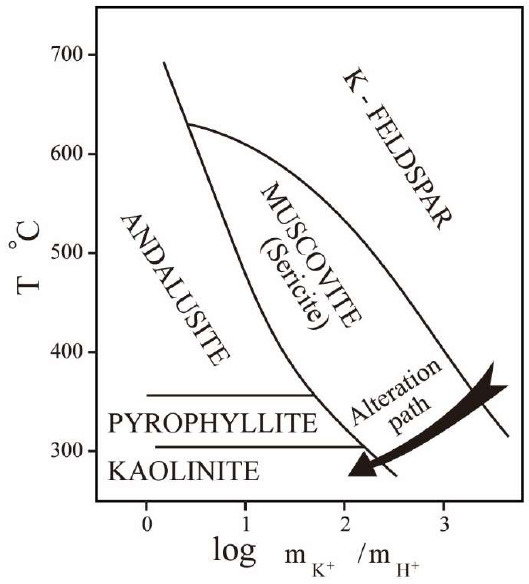
Figure 5. Sketch map of alteration zoning in the strong altered wall-rock from the Eunjeok deposit.